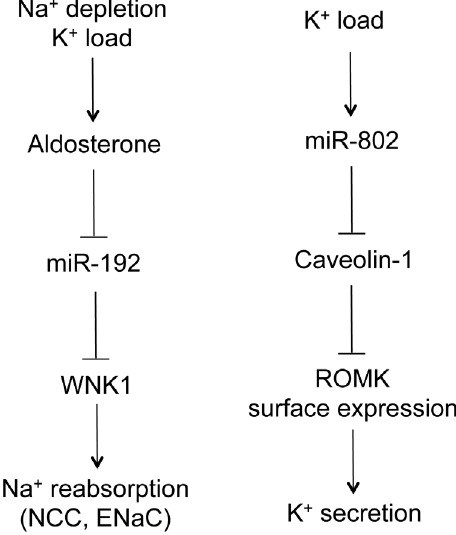
Figure 4. The role of microRNA in Na + and K + handling by the distal nephron. Na + depletion or K + load increases serum aldosterone level, which decreases miR-192 levels in the aldosterone-sensitive distal nephron (ASDN). MiR-192 suppresses WNK1 gene expression, which in turn regulates Na + reabsorption through the NCC and ENaC